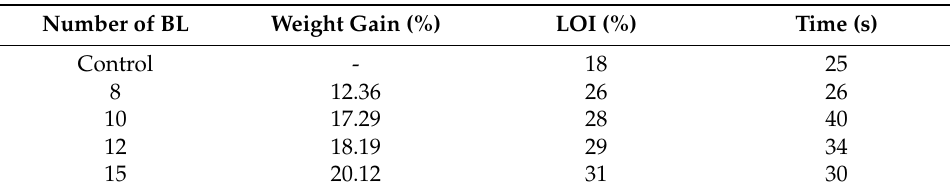
Table 1. Weight gain and limiting oxygen index data.